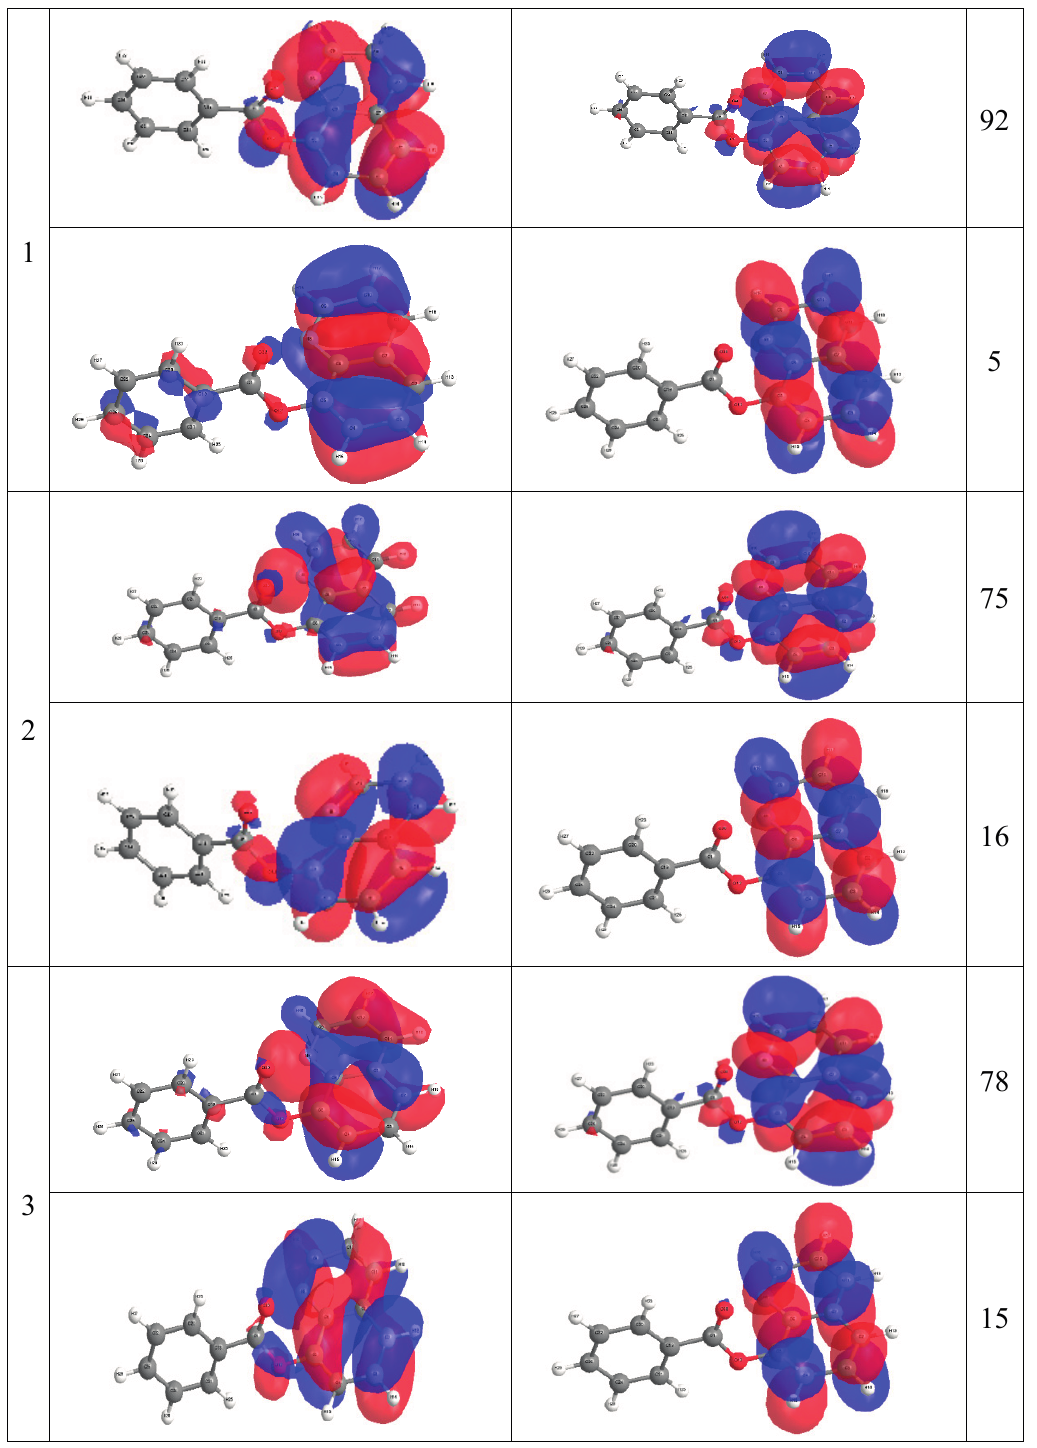
Figure 6. Natural transition orbital for 8-OateQ-syn compound at CAM-B3LYP/6-311++G** level of